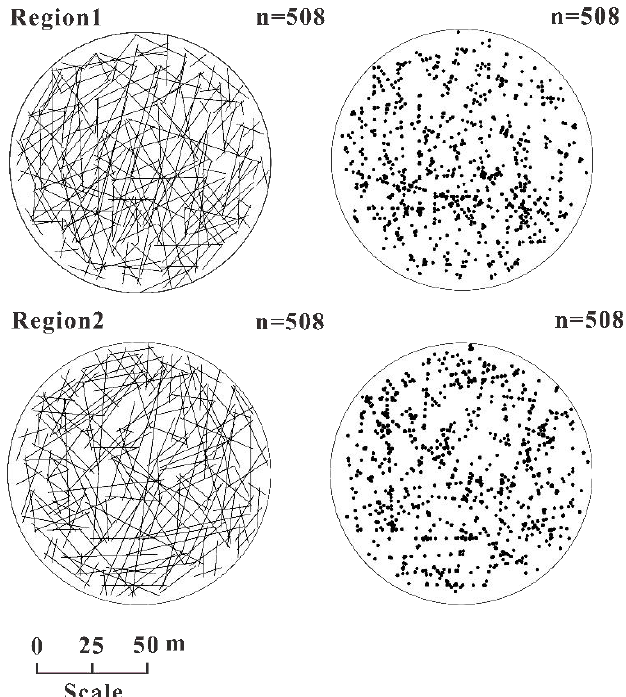
Figure 16. Digital lineament strength and density map. Lineaments extracted from study area 1 and 2 by the traditional Canny algorithm (n represents the number and intersections of lineaments).